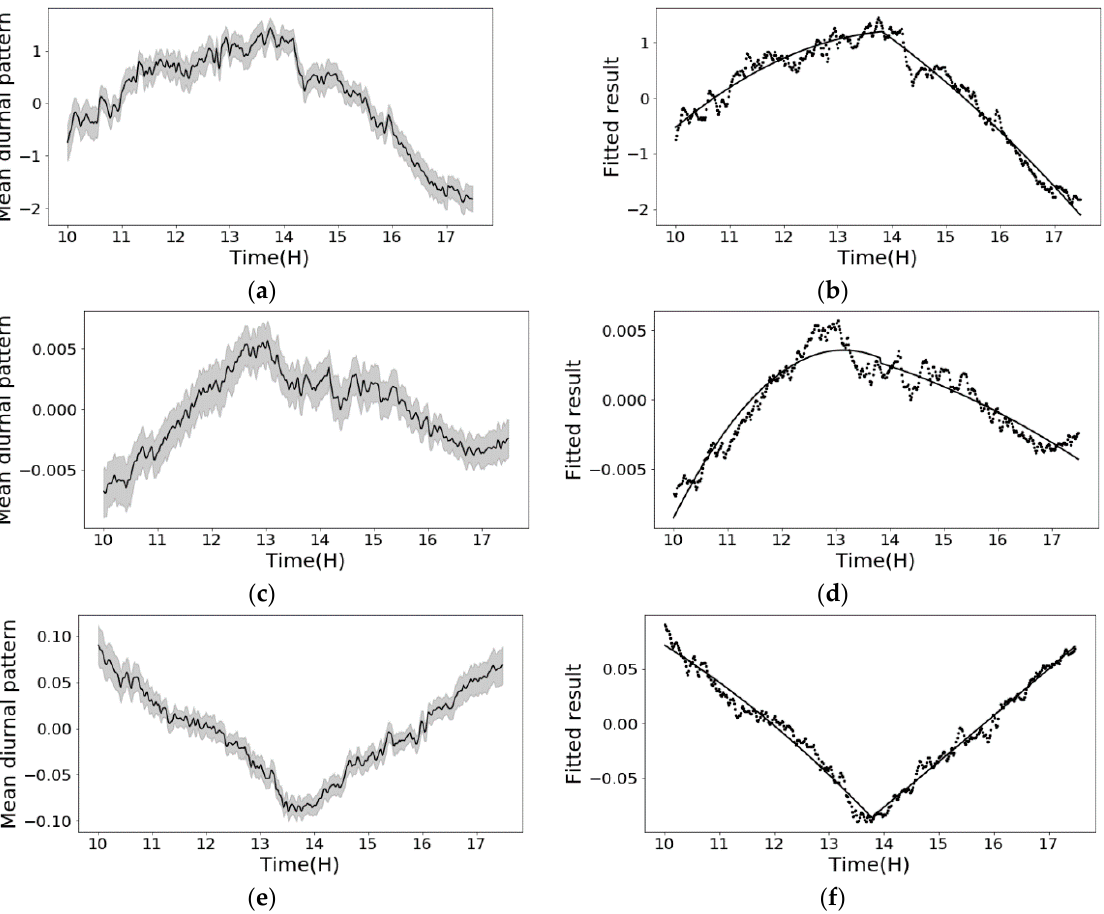
Figure 10. The mean diurnal patterns and fitted results of other plant phenotyping features including RWC, Red and NIR. ( a ) RWC, diurnal pattern; ( b ) RWC, fitted result; ( c ) Red, diurnal pattern; ( d ) Red, fitted result; ( e ) NIR, diurnal pattern; ( f ) NIR, fitted result. Table 8. The fitted results of other plant phenotyping features.